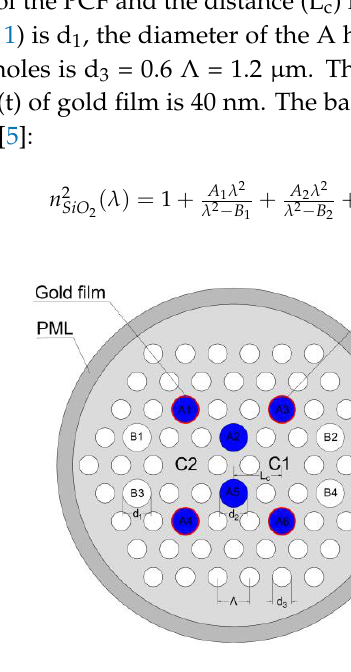
Figure 2. ( Left ): Dispersion relationship between the fundamental mode and the surface plasmon polaritons (SPP) mode with n = 1.46; ( Right ): Dispersion relationship between the fundamental mode and the SPP mode with n = 1.49.